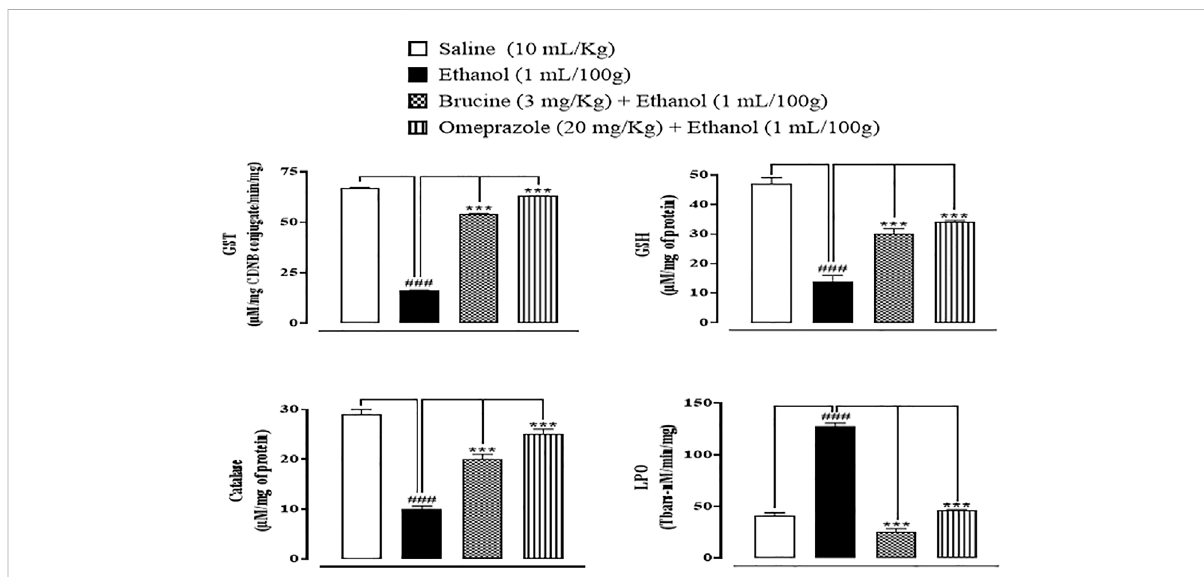
FIGURE 4 Effectofbrucineandomeprazoleagainstglutathionesulfotransferases(GST),reducedglutathione(GSH),catalase,andlipidperoxidase(LPO)in ethanol-induced ulcer rat gastric tissues. Data presented as mean ± SEM ( n = 5). One-way ANOVA with post hoc Tukey ’ s test. ### p < 0.001 vs. saline group; ppp p < 0.001 vs. ethanol